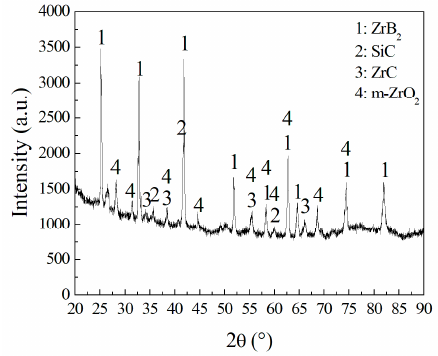
Figure 2. XRD pattern of laser cladding coating.